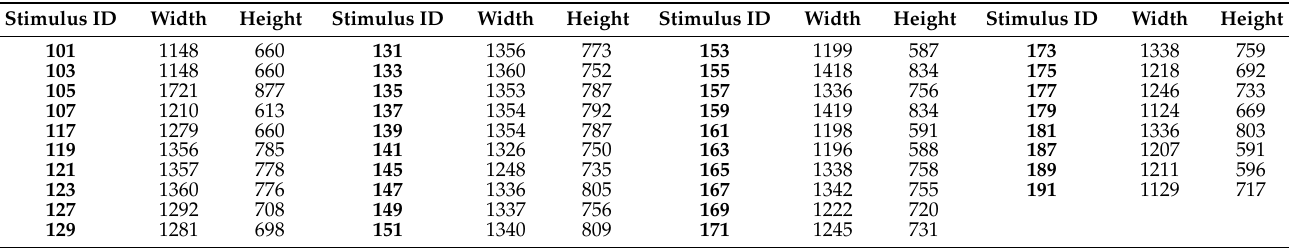
Table A2. The resolutions of the stimuli